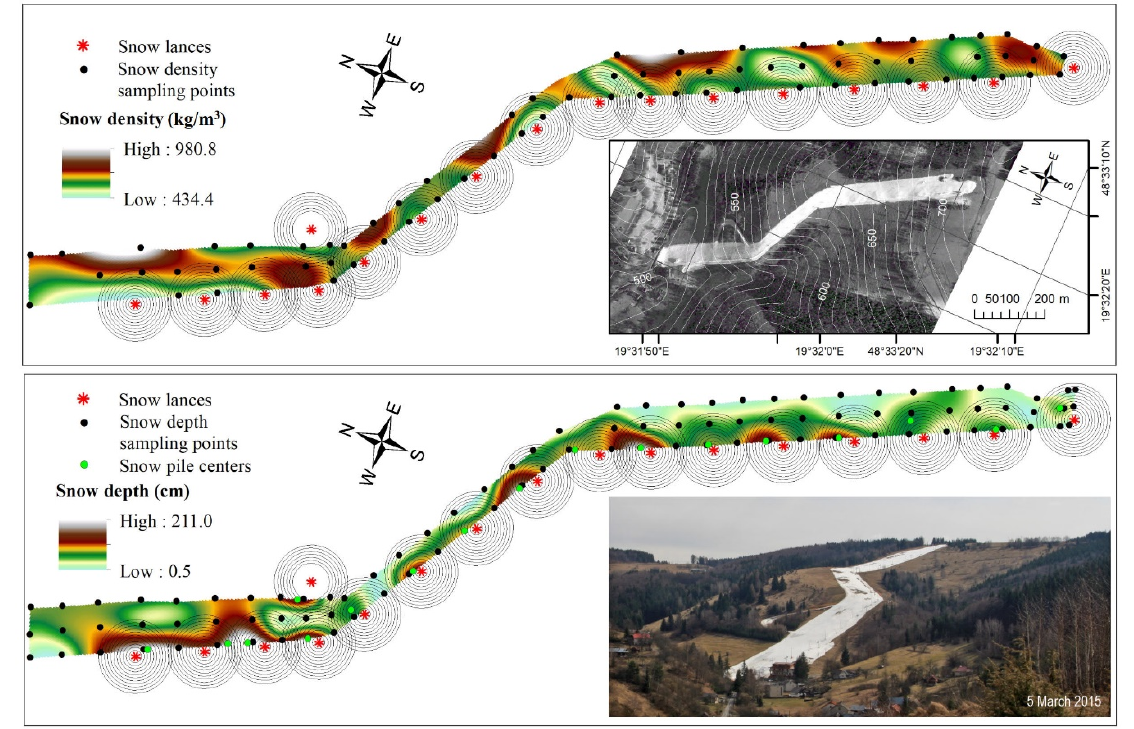
Figure 8. Snow densities and depth mapping of the ski piste snowpack for 5 March 2015, after the disappearance of natural snow from the off-piste sites. Displayed are snow pile centers (points of maximum snow depth within a 20 m radius around snow lances) and concentric circles around snow-making lances with 5 m spacing and maximum radii of 30 m.